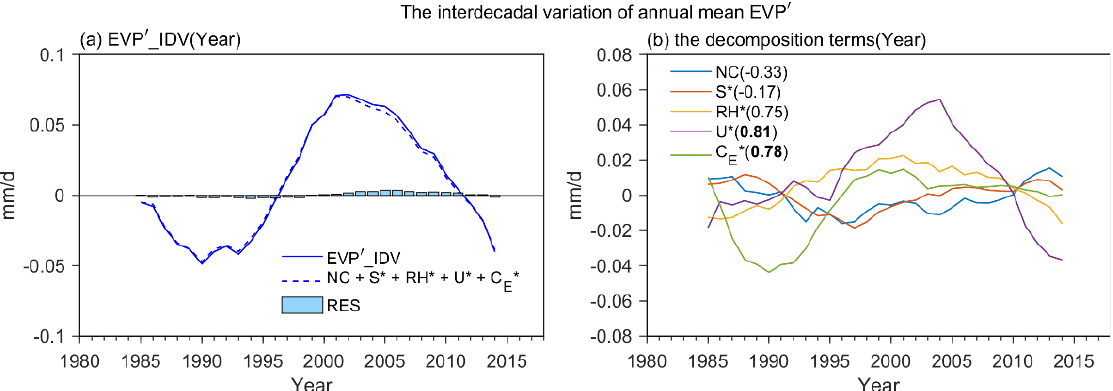
Figure 3. ( a ) Time series of the interdecadal variation of annual mean EVP (cid:48) (blue solid line), the sum of the interdecadal variations of Newtonian cooling term (NC), surface stability term (S*), relative humidity term (RH*), wind speed term (U*), exchange coefficient term (C E *) (blue dashed line), and residual term (RES, blue bars) over the tropical Indian Ocean. ( b ) The interdecadal variation of annual mean NC, S*, RH*, U*, and C E *. The correlation coefficients between the interdecadal variations of EVP (cid:48) and the decomposition terms are written in brackets (correlations significant with the 95% confidence level are in bold). All units are in mm/d.